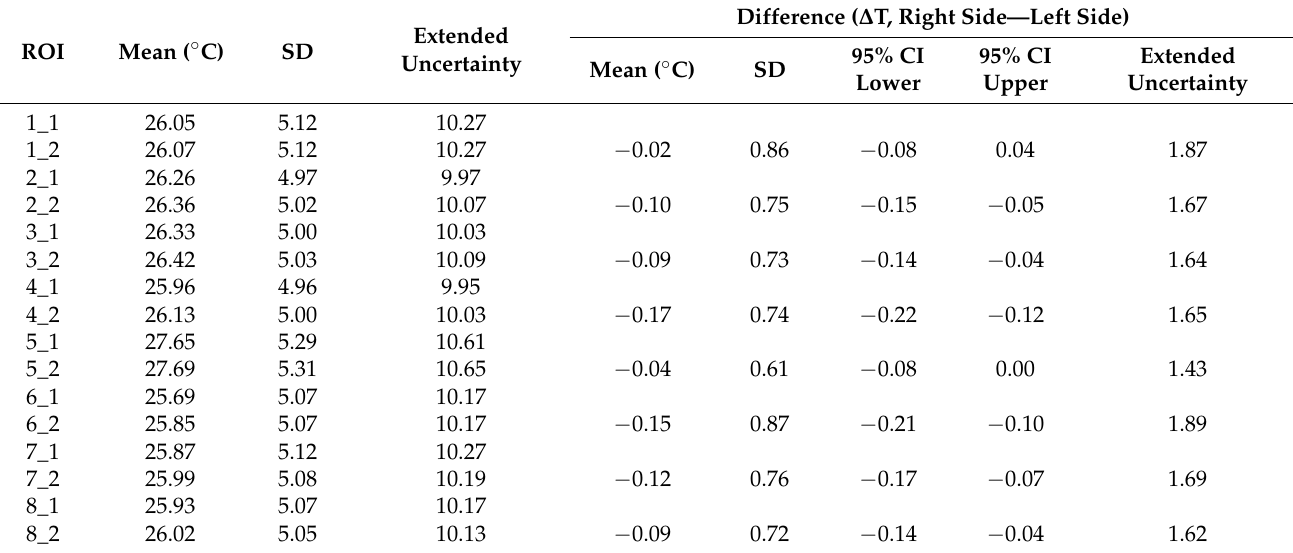
Table 4. Overall mean temperature of regions of interest in the sole